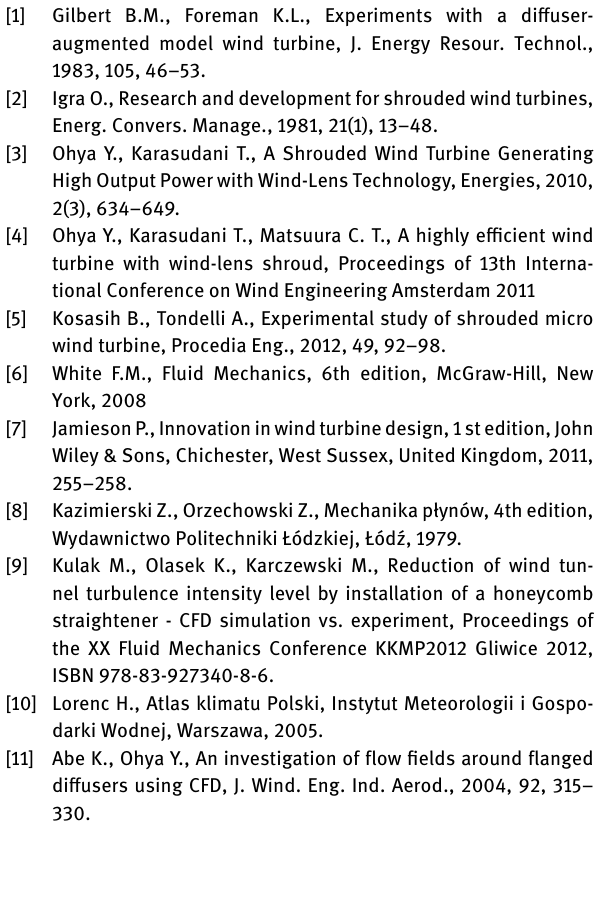
Figure 11: Streamwise flow velocity distribution for the case 2 α =6°and varying brim heights.